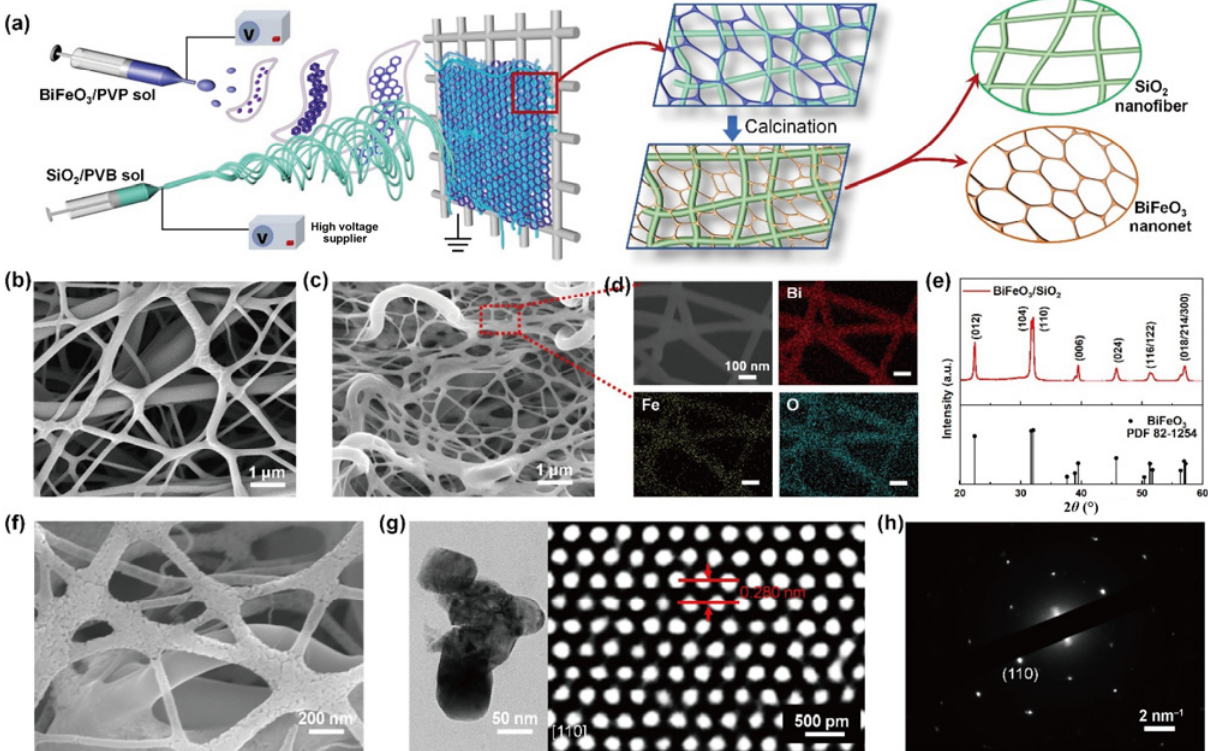
Fig. 1 Fabrication process and structural characterization of BiFeO 3 /SiO 2 composite membrane. (a) Schematic showing the double-needle-based electronetting/electrospun process for preparing BiFeO 3 /SiO 2 membrane. Low-magnification SEM images showing the nanonet/fiber structure of the composite membrane (b) before and (c) after calcination. (d) Elemental mappings of the nanonets, indicating the uniform distributions of Bi, Fe, and O elements. (e) XRD patterns of pure BiFeO 3 and BiFeO 3 /SiO 2 fibrous membrane. (f) High-magnification SEM image of the BiFeO 3 /SiO 2 membrane. (g) High-resolution TEM (HRTEM) image and (h) corresponding selected-area electron diffraction (SAED) pattern of BiFeO 3